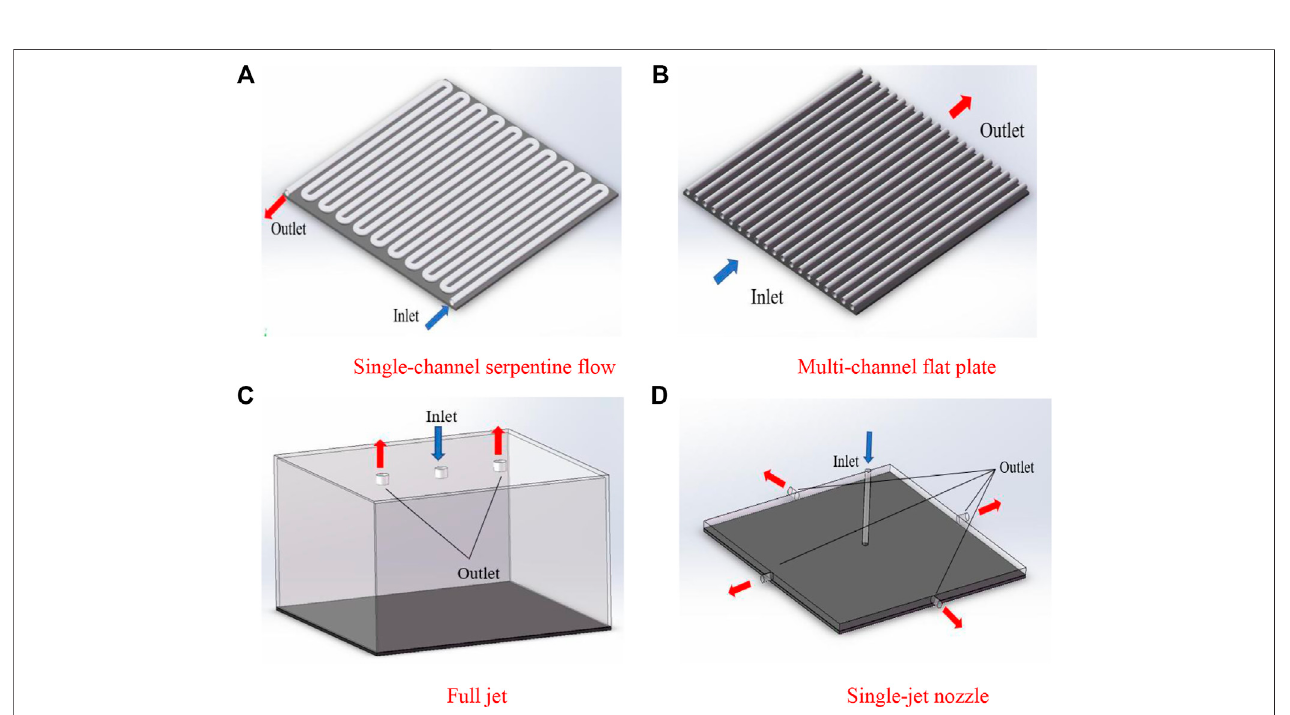
FIGURE2| Fourdifferentsolarconcentrationphotovoltaiccoolingheatexchangers. (A) Single-channelserpentine fl ow; (B) Multi-channel fl atplate; (C) Fulljet;and (D) Single-jet nozzle.